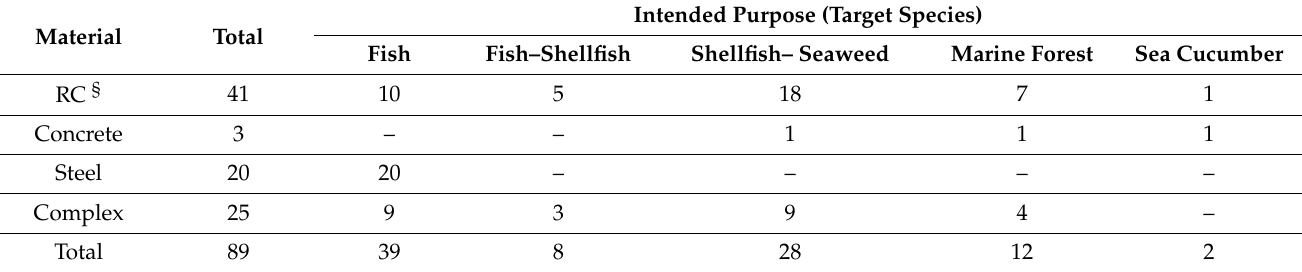
Table 4. Classification of artificial reefs used in South Korea [356]. The numbers have changed according to newly approved or de-approved artificial reefs.